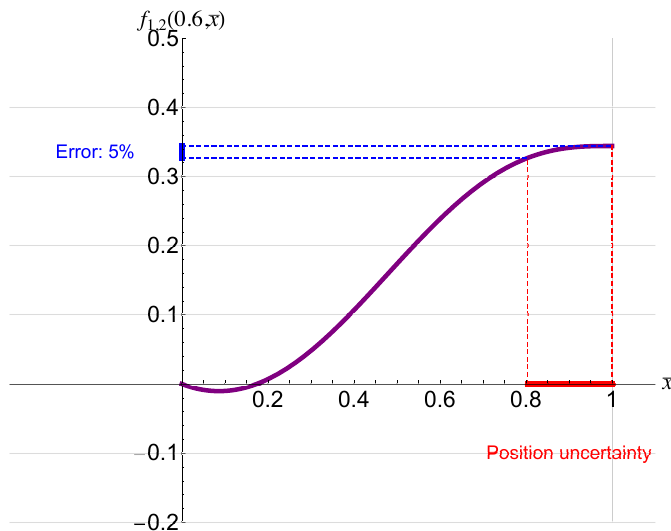
Figure 14. Uncertainty of the position due to error in the measuring equipment.